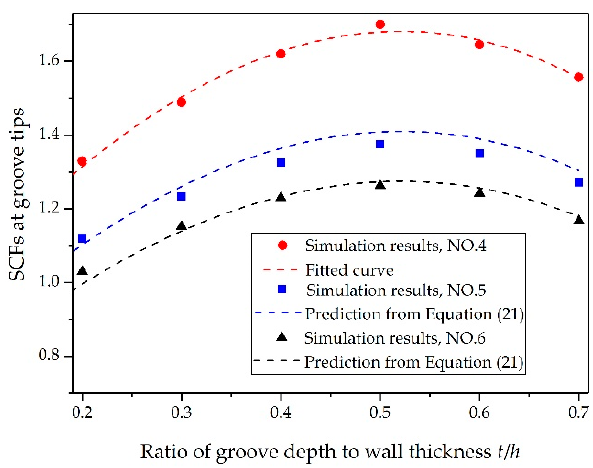
Figure 10. Relationship between t / h and SCFs at groove tips.